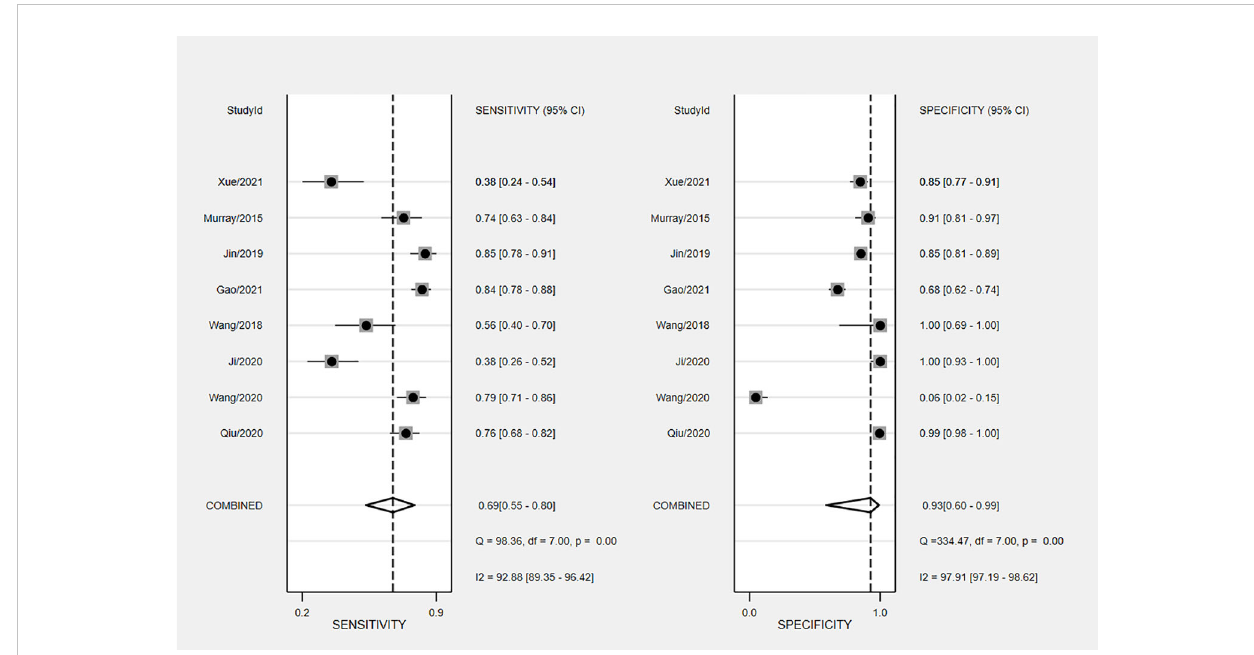
FIGURE 4 Fagan nomogram plot analysis for the evaluation of CTCs as a diagnostic tool for detecting BC.